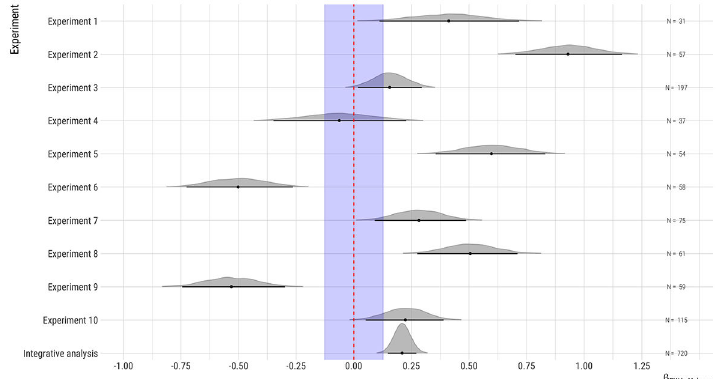
Note. The purple area corresponds to a region of practical equivalence where the values are considered equivalent to 0 (Kruschke, 2018). More information can be found in the Supplementary Materials.